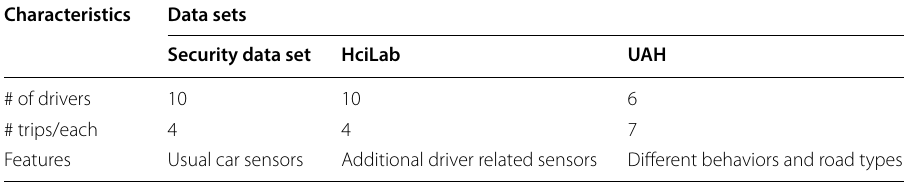
Table 1 Characteristics of the used datasets (more details in the third section) Characteristics Data sets